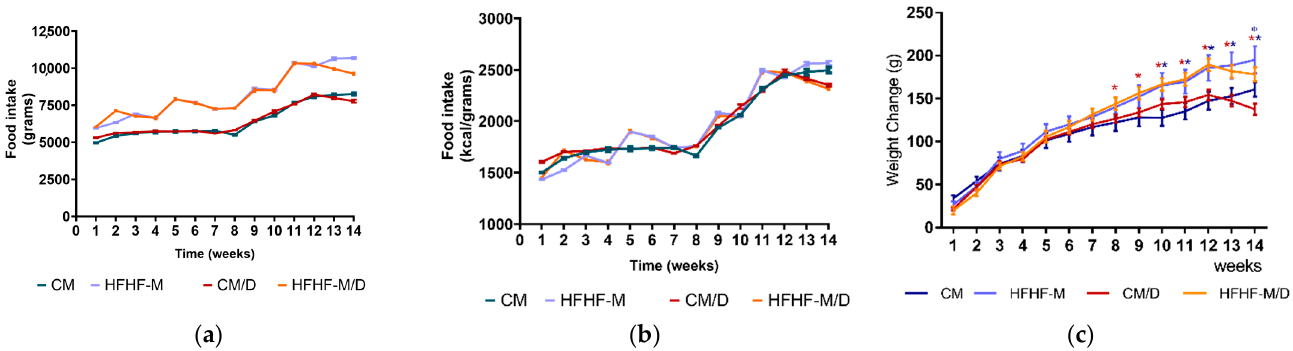
Figure 5. Effect after 14 days of compound 1b administration on food intake and weight change on the MetS animal model ( a ) food consumption, ( b ) calorie intake, ( c ) weight change. HFHF-M and HFHF-M/D groups presented a statistically significant increase in kg/cal consumption compared to control (CM and CM/D) groups, observing significant weight differences between groups from week 8 to week 12. After 14 days of treatment with compound 1b , the HFHF-M/D group had a reduction of weight change on both treated groups (CM/D and HFHF/D) being non-statistically significant between HFHF-M and HFHF-M/D. Data are presented as means ± standard deviation (SD). * Represents statistically significant differences between groups compared to their own control group (CM vs HFHF-M) (CM/D vs HFHF-M/D) ( p < 0.05). The color of the * represents which group is the compared to their control.